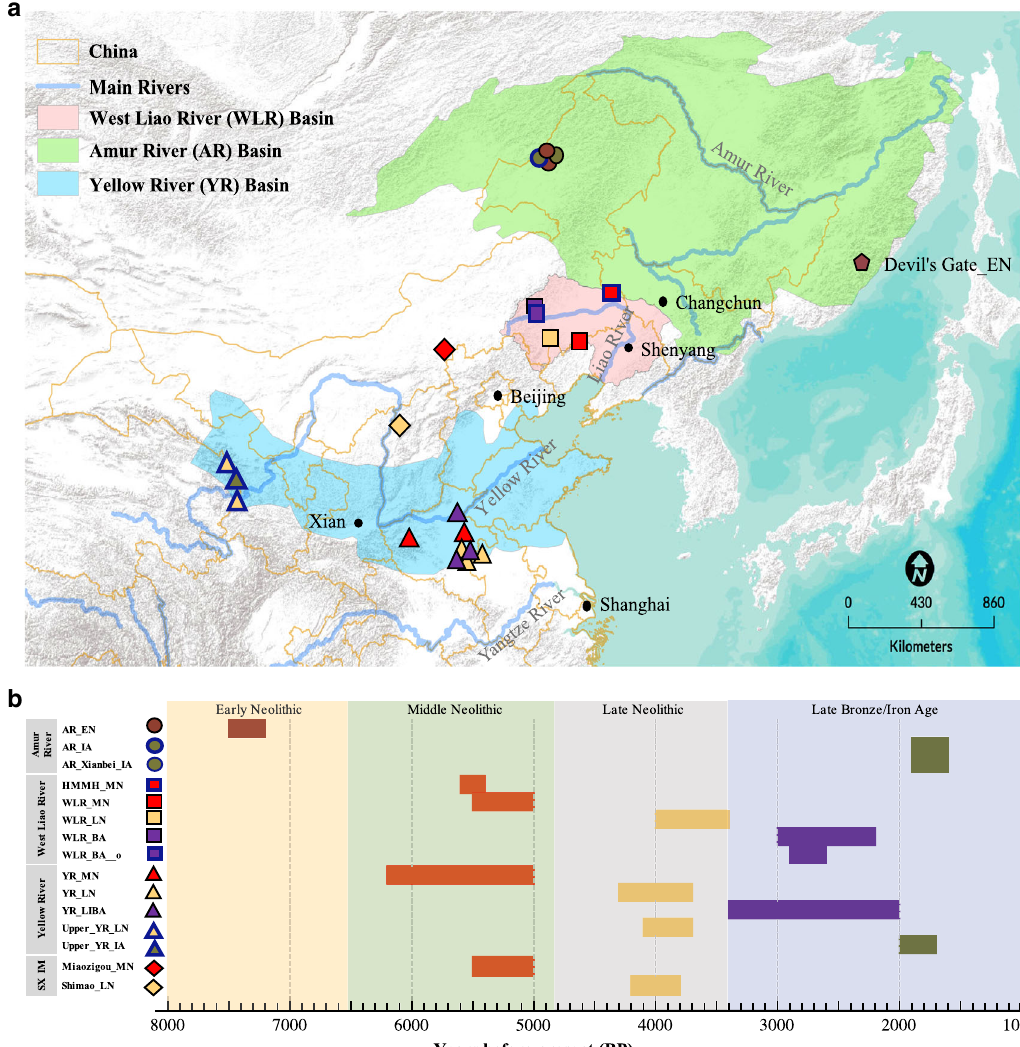
Fig. 1 Geographic location and dates of ancient individuals. a Location of the 19 archeological sites covering 55 ancient individuals in this study. Each symbol corresponds to a site from a speci fi c region: circle (AR); square (WLR); triangle (YR); diamond (sites from Inner Mongolia or Shaanxi) (see Table 1 for details). The published Early Neolithic genomes from the Russian Far East ( “ Devil ’ s Gate_EN ” ) 57,58 are also indicated. The three major river basins in northern China are indicated in different color shades, namely Amur River Basin in light green, West Liao River Basin in pink, and Yellow River Basin in light blue. The base map was prepared from the ArcGIS “ World Terrain Base ” included in the ArcGIS desktop standard v. 9.2. ArcGIS user license was purchased by, and authorized to, the Max Planck Institute for the Science of Human History (MPI-SHH, Jena, Germany). b Calibrated radiocarbon dates and relative dating of ancient samples in this study. The archeological sites are ordered according to their locations. SX and IM refer to Shaanxi province and the Inner Mongolia Autonomous region of China, respectively. Their geographic locations are intermediate between the WLR and YR. Colors correspond to samples of different time periods: EN Early Neolithic, MN Middle Neolithic, LN Late Neolithic, BA Bronze Age, LBIA Late Bronze and Iron Age, IA Iron